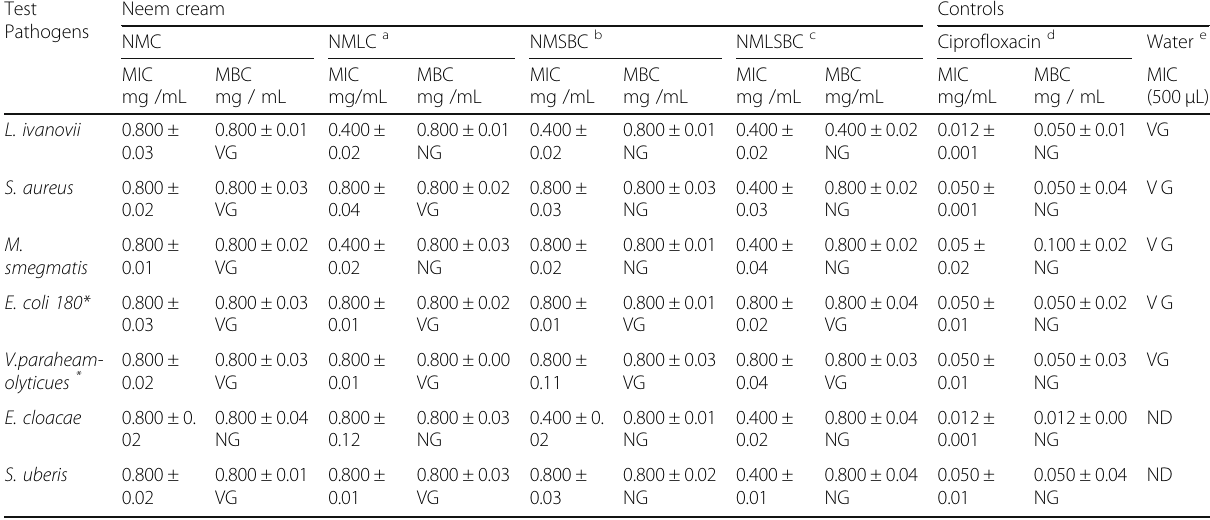
Table 4 Neem cream minimum inhibitory and minimum bactericidal concentrations (MIC & MBC) Test